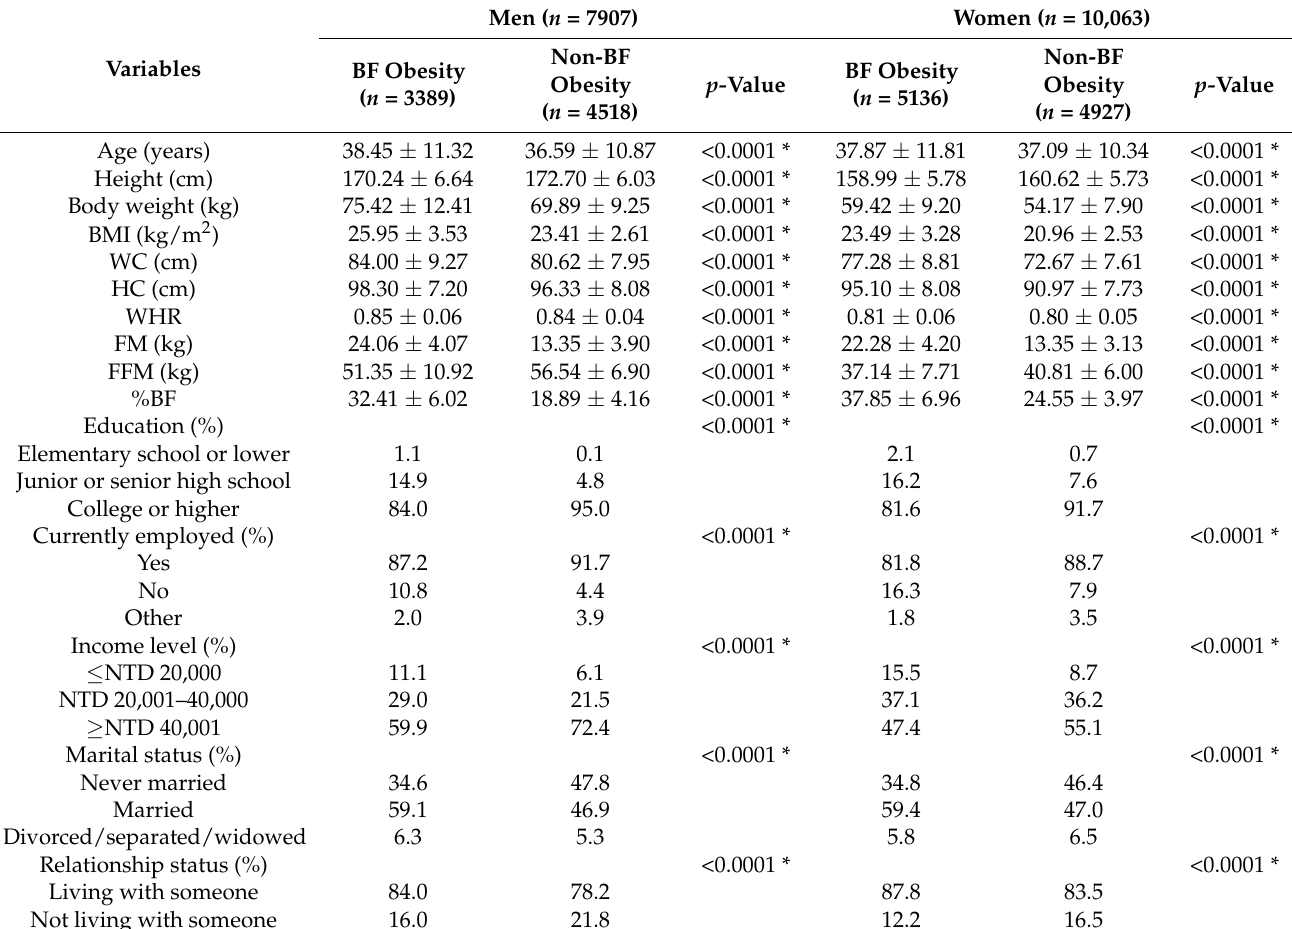
Table 1. Anthropometric and sociodemographic characteristics of the study participants, who were Taiwanese adults, with or without body fat obesity.